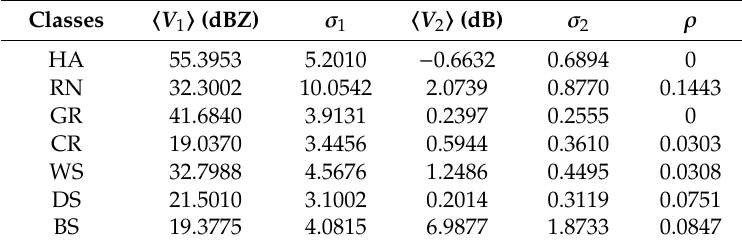
Table 3. Mean value (cid:104) V 1 (cid:105) ( (cid:104) V 2 (cid:105) ) and standard deviation σ 1 ( σ 2 ) for variable Z H (Z DR ) and correlation coe ffi cient ρ in Equation